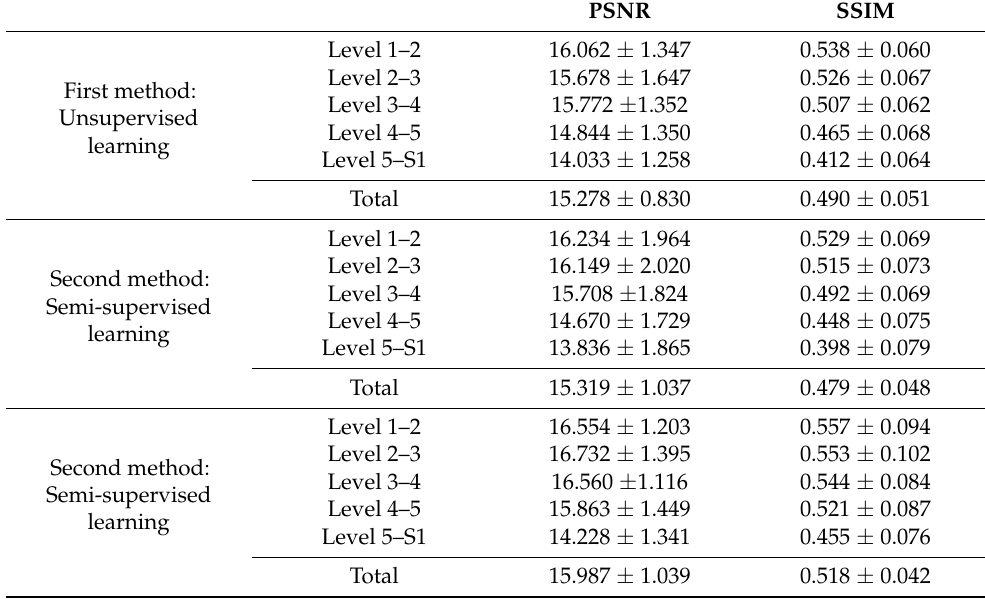
Table 5. Overall statistics for two measures of model quality for three algorithms (unsupervised, semi-supervised, and supervised): PSNR and SSIM. The average and standard deviation for each measure about from axial slices of the 5 spine levels among the 59 subjects in our test